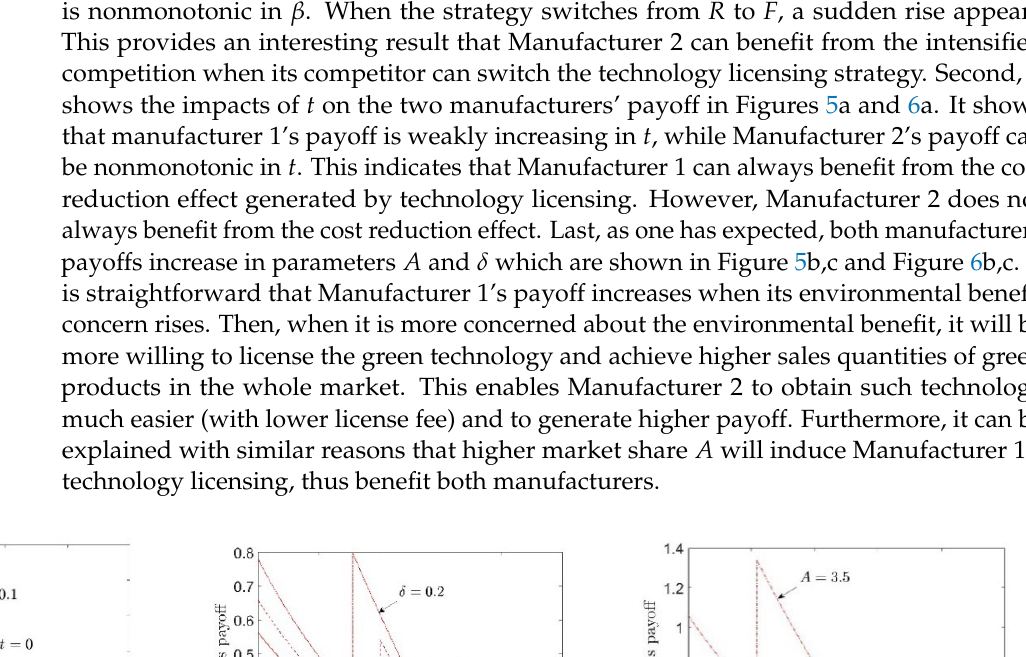
Figure 5. Impacts of